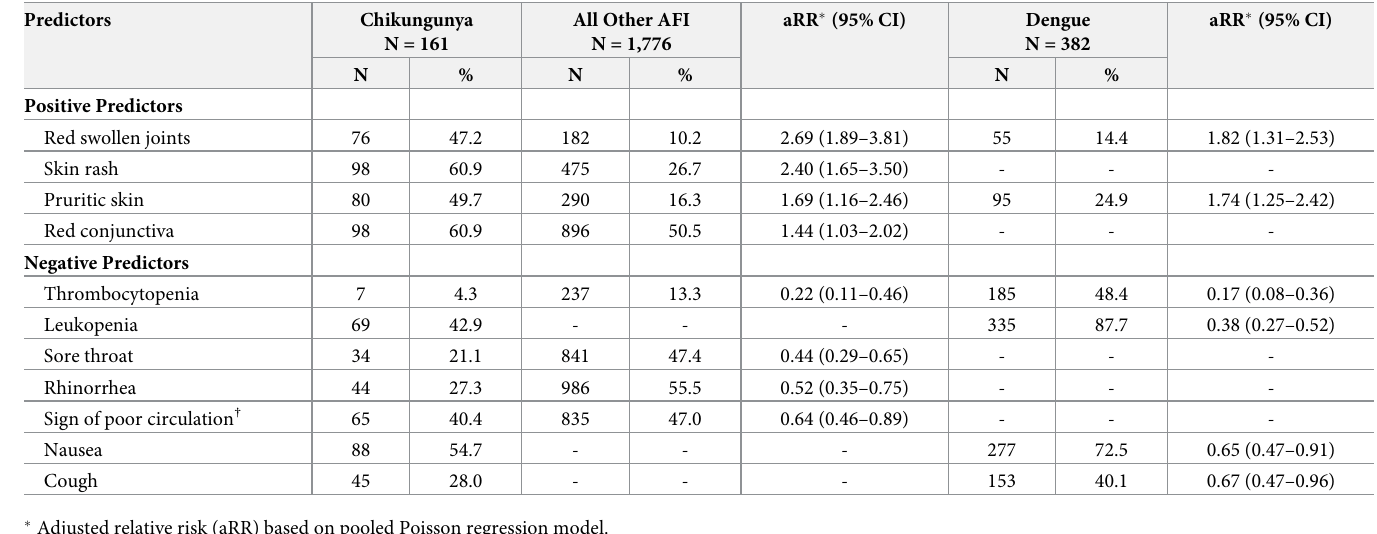
Table 6. Late predictors of laboratory-confirmed chikungunya versus all other acute febrile illnesses or laboratory-confirmed dengue for participants of all ages, Acute Febrile Illness Study, May 7, 2012–May 6, 2015, Puerto Rico.